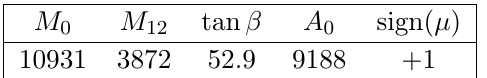
Table 2. The CMSSM parameter values (in GeV when applicable) of Point